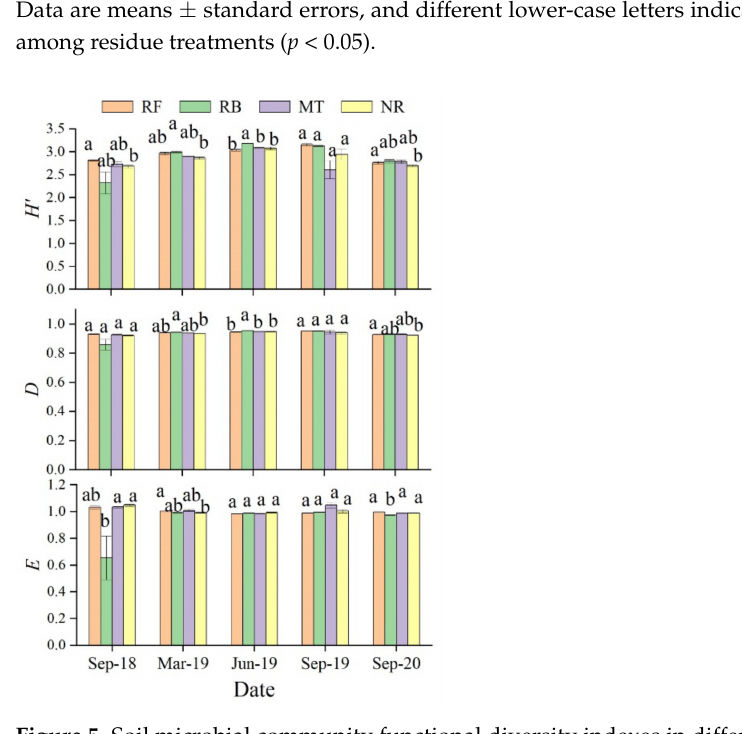
Figure 5. Soil microbial community functional diversity indexes in different treatments of harvest residue at 96 h. H’ , Shannon–Wiener diversity index; D , Simpson dominance index; E , McIntosh evenness index. Data are means ± standard errors. Different lower-case letters indicate significant differences among the residue treatments ( p <